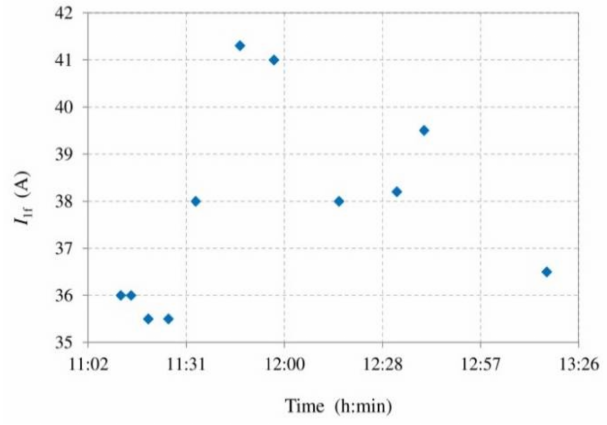
Figure 8. Average electric current flowing into the electric motor through one